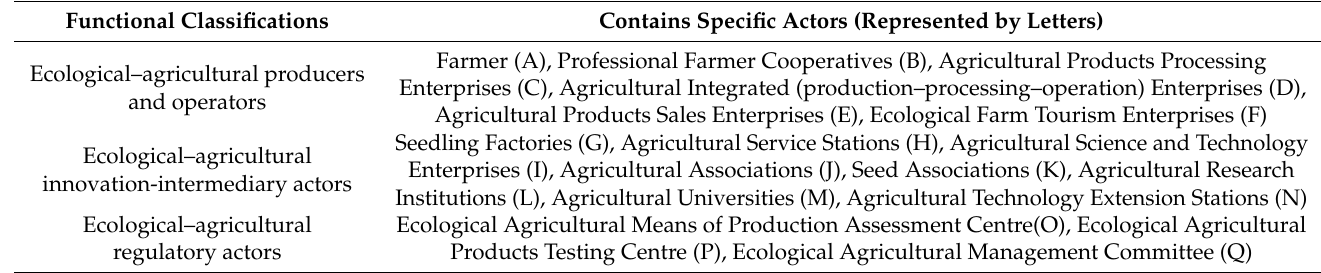
Table 1. List of the classifications of ecological agriculture actors and the subtypes of each actor group. Functional Classifications Contains Specific Actors (Represented by